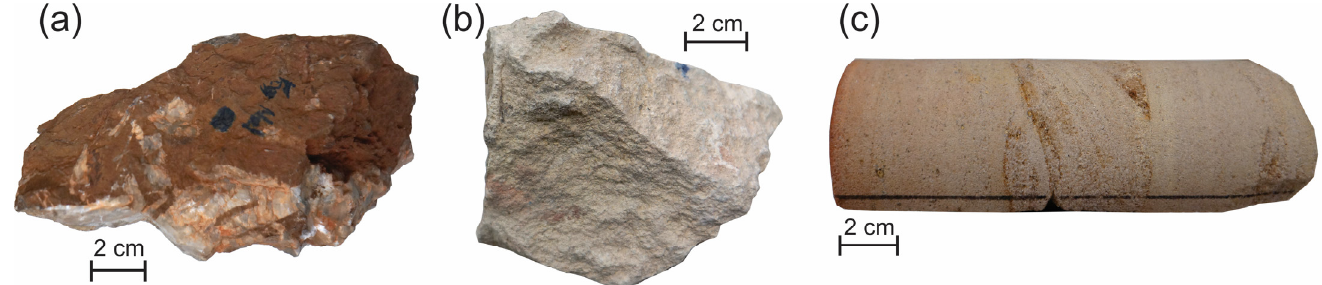
Figure 13. Rock samples used in the methodology validation test. ( a ) Sample 1, ( b ) Sample 2 and ( c ) Sample 3.